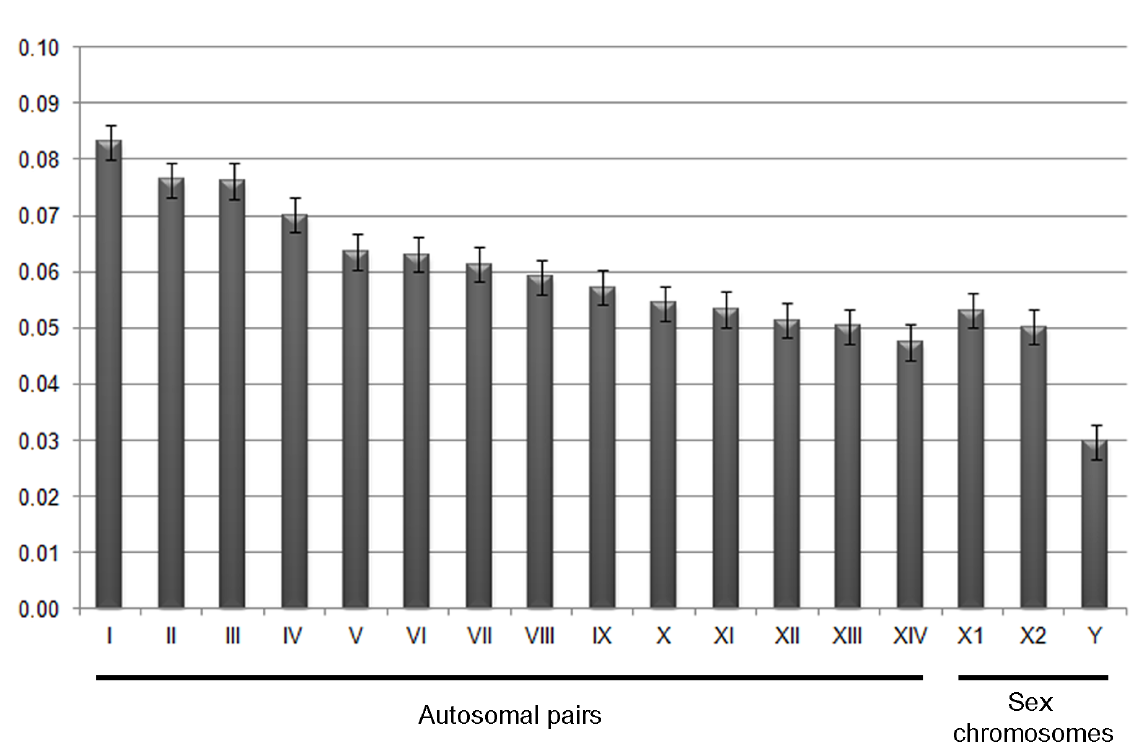
Figure 3. Male ideogram of Cyanolicimex patagonicus . 2n= 31= 28A+X chromosomes were put in the y- and x-axes,